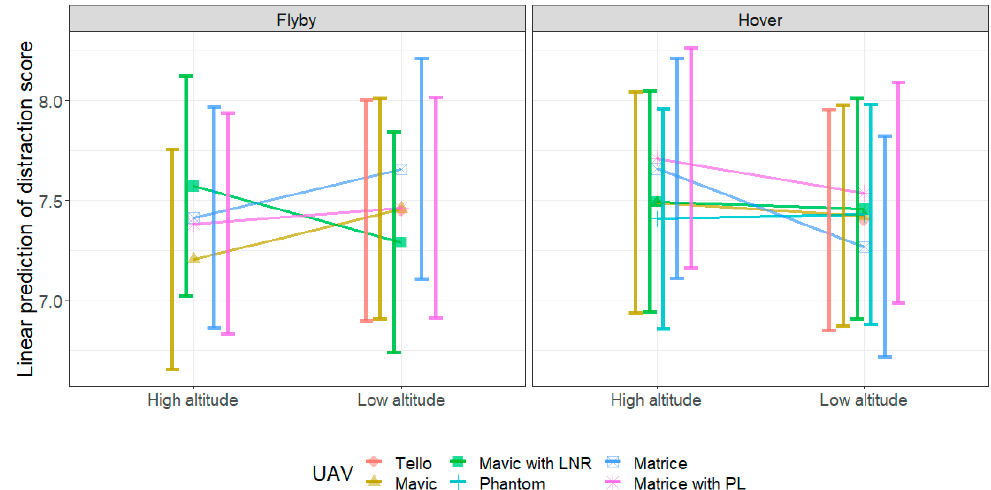
Figure 15. Linear prediction of distraction scores from the linear mixed model analysis in terms of altitude conditions. The error bars represent the 95% confidence interval of the linear prediction.